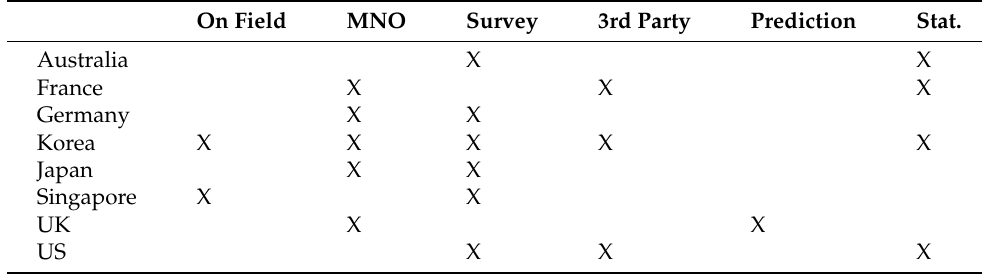
Table 4. Data-obtaining